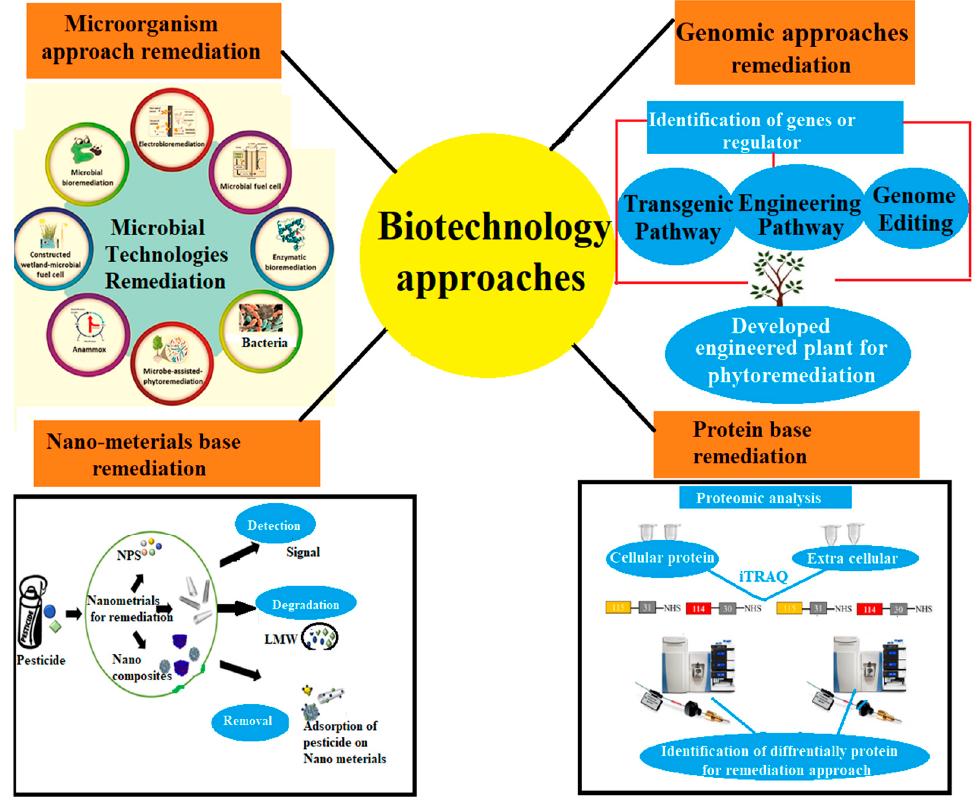
Figure 3. Biotechnology approaches that enhance remediation strategies.